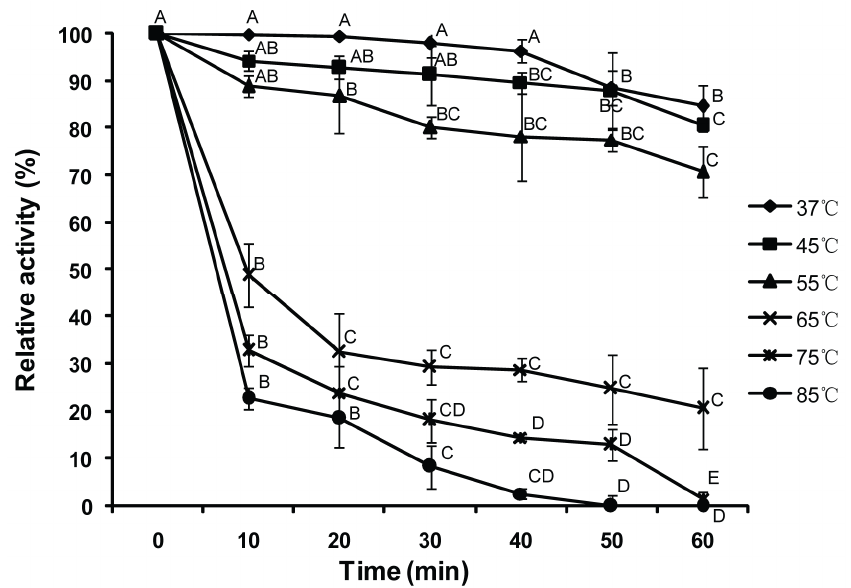
Figure 5. Effects of temperature on the purified recombinant Bt-mMnSOD activity. Each bar represents the mean ± SD ( n = 3). For each temperature, significant differences are indicated by different letters at p < 0.01 (least significant difference (LSD)